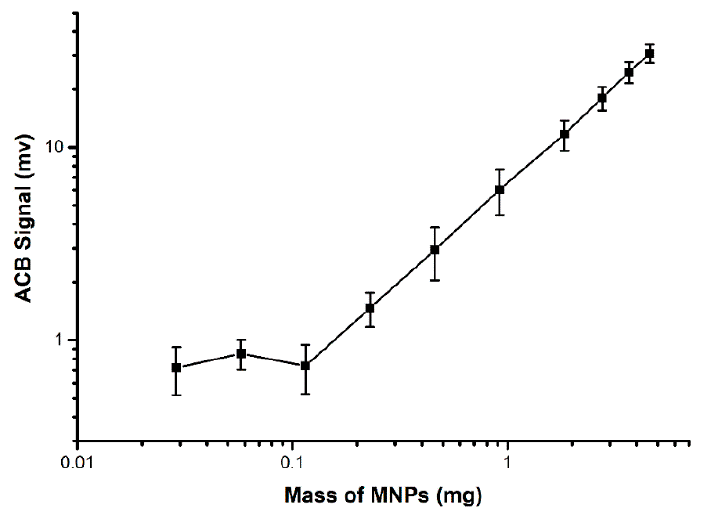
Figure 2. Calibration curve of citrate ‐ coated MNPs in linear scale with linear fits, where an R² = 0.99 was obtained for citrate ‐ coated MNPs.